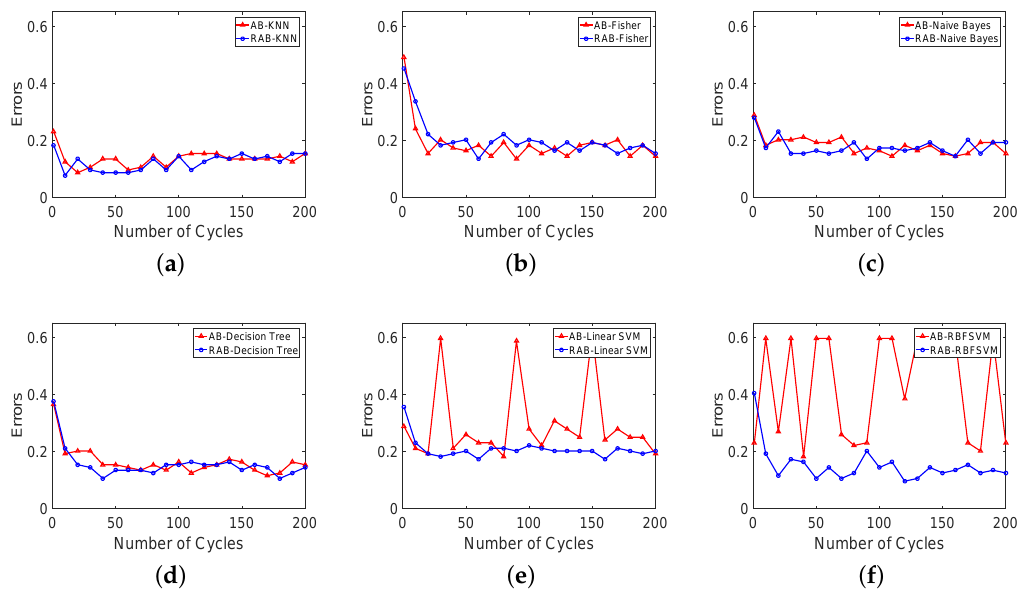
Figure 10. Performances of AdaBoost and Robust AdaBoost with different component classifiers. ( a ) Training errors of AB-KNN and RAB-KNN; ( b ) Training errors of AB-Fisher and RAB-Fisher; ( c ) Training errors of AB-Naive Bayes and RAB Naive Bayes; ( d ) Training errors of AB-Decision Tree and RAB-Decision Tree; ( e ) Training errors of AB-Linear SVM and RAB-Linear SVM; ( f ) Training errors of AB-RBFSVM and RAB-RBFSVM.